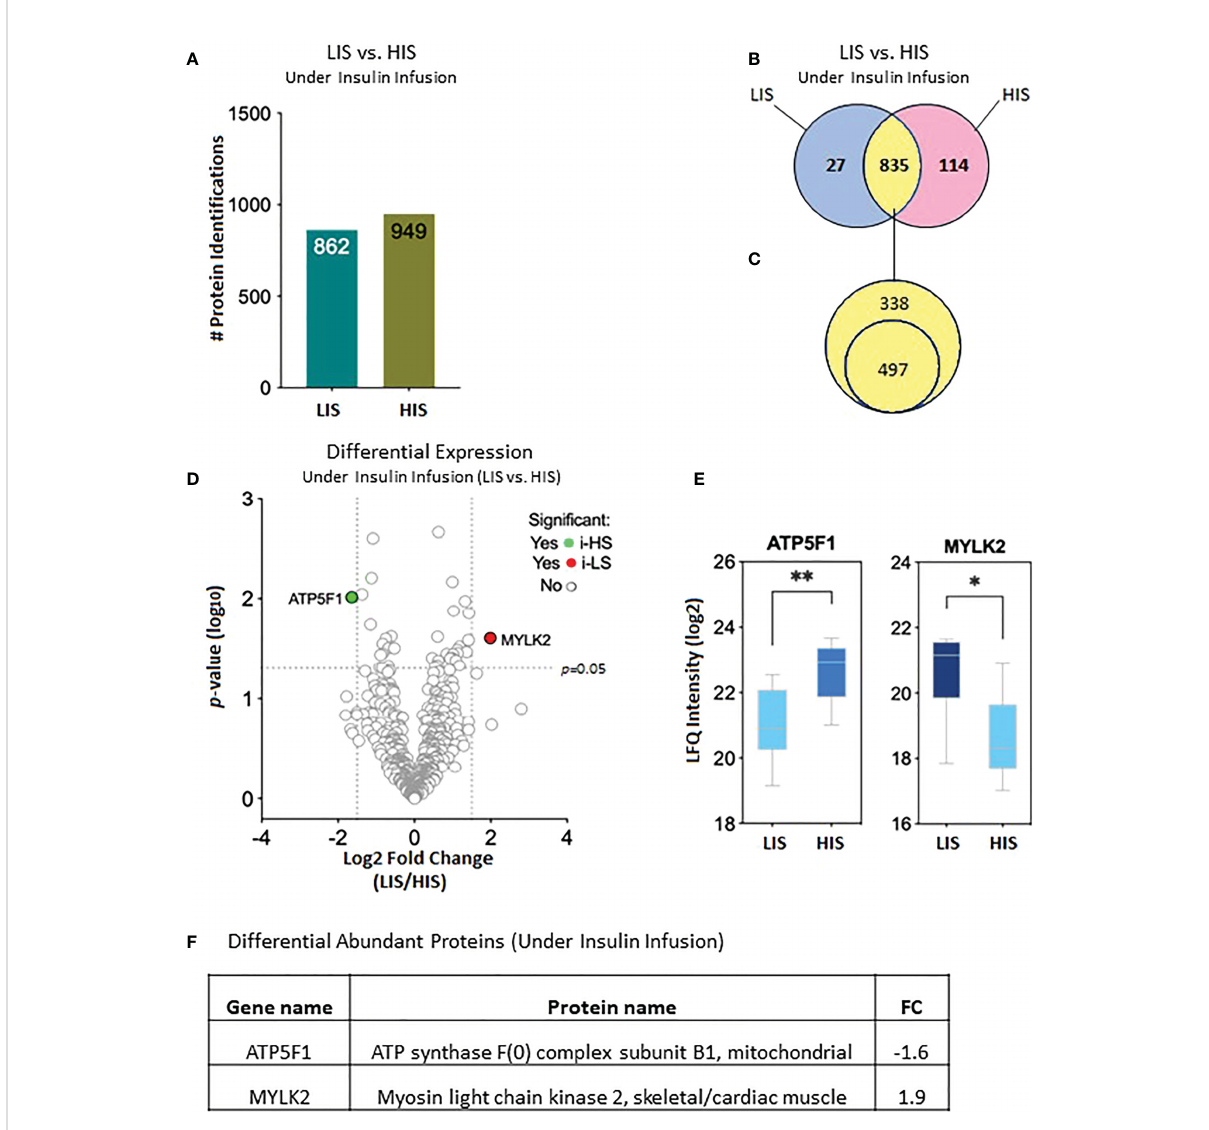
FIGURE 5 Effects of insulin (2 h infusion) on protein levels in the subjects with low insulin sensitivity (LIS) versus the subjects with high insulin sensitivity (HIS). (A) Bar chart representing the number of proteins identi fi ed in each group. (B) Venn diagram showing the unique and common proteins in response to clamp. (C) Proteins sorted for their presence in at least 50% of the subjects. (D) . Volcano plot showing the differential abundance of proteins between the groups after 2 hours of insulin infusion during the HIEC. (E) Box plots representing the proteins with a signi fi cant differential abundance. *p=0.01, **p=0.001. (F) Fold changes in the proteins showing statistically signi fi cant differential abundance in LIS versus HIS under-insulin